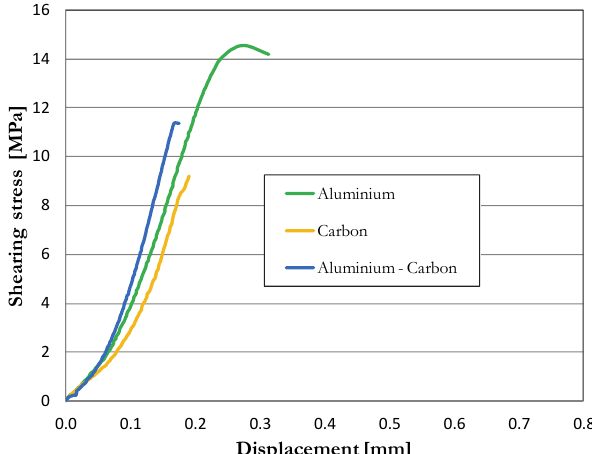
Figure 11: Relative shearing displacements for adherends of 3 mm.